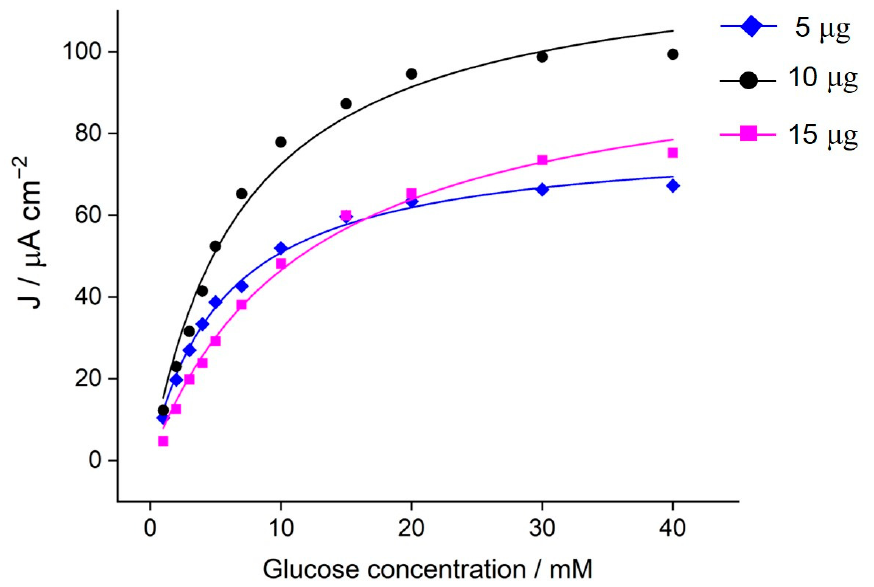
Figure 3. Effect of GDH load on the poly(TBO)/rGO/GCE on the catalytic current. Chronoamperometry was performed in the presence of 5 mM NAD + in 0.1 M phosphate buffer pH 7.4 at the applied potential of 0.2 V vs. Ag/AgCl 3 M KCl. Solid curves correspond to Michaelis–Menten fits (see Table S2 for details).